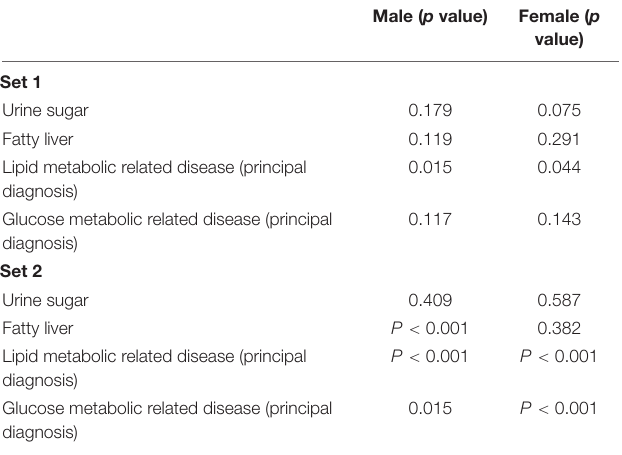
TABLE 3 | Analysis using Pearson’s chi-square test.